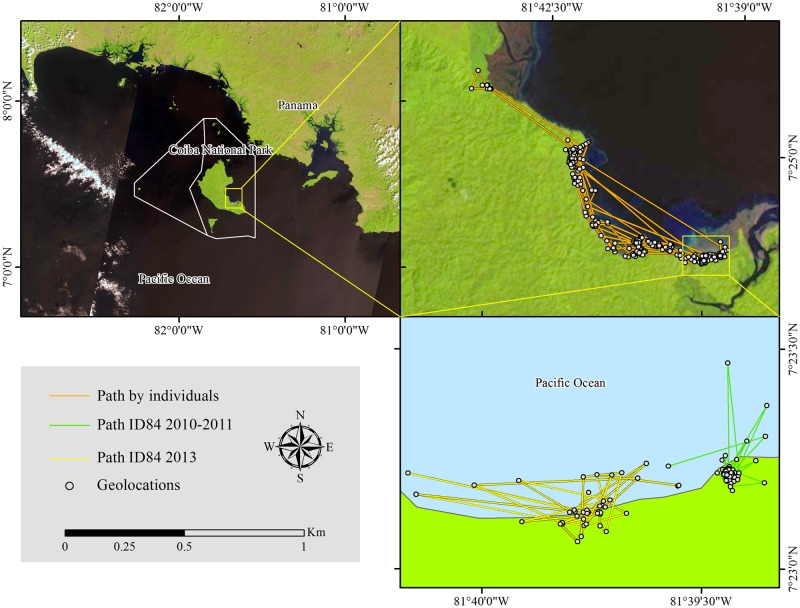
Trajectory movements.Trajectory movements of all the American crocodile individuals followed between 2010 and 2013 in Coiba Island, highlighting the differences in the trajectory of individual ID84, which expanded its movement area without overlapping with the previously estimated one.